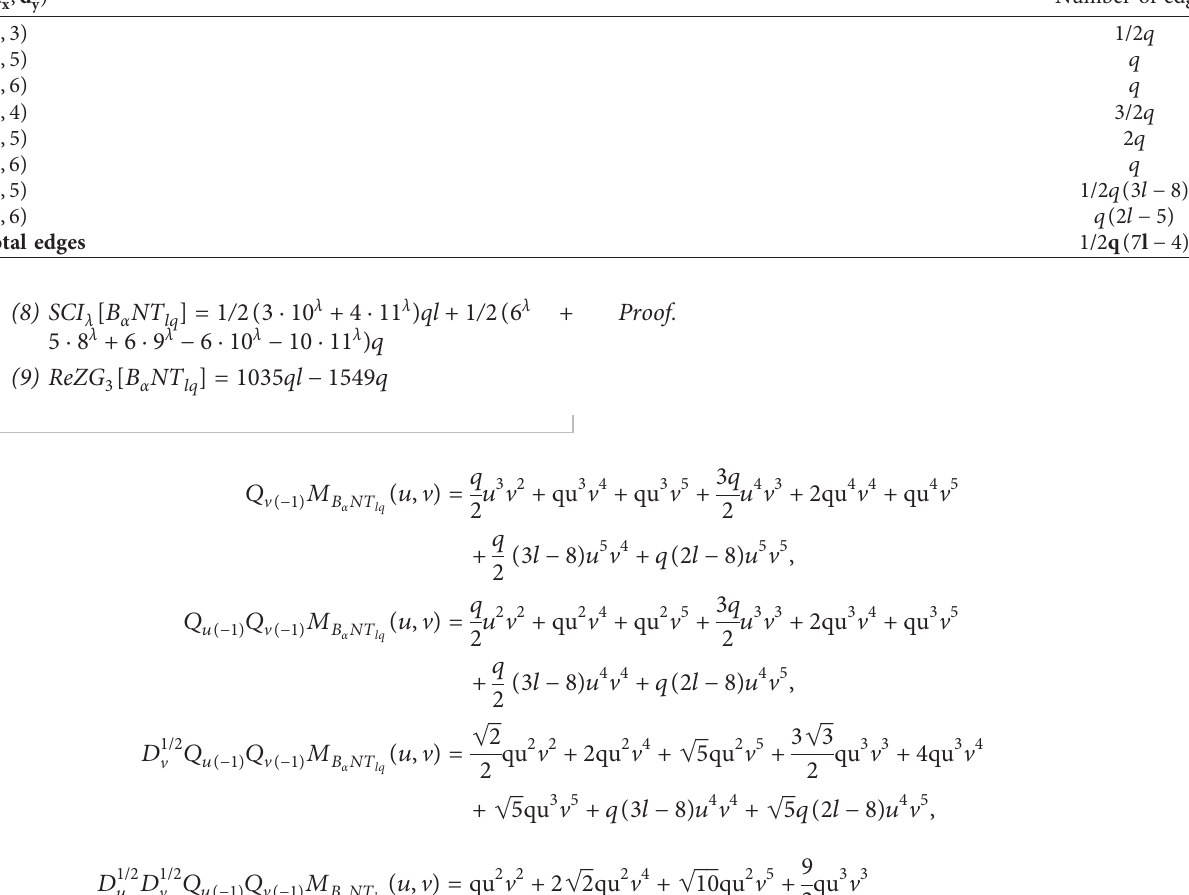
Table 3: Edge partition of boron α -nanotube ( B